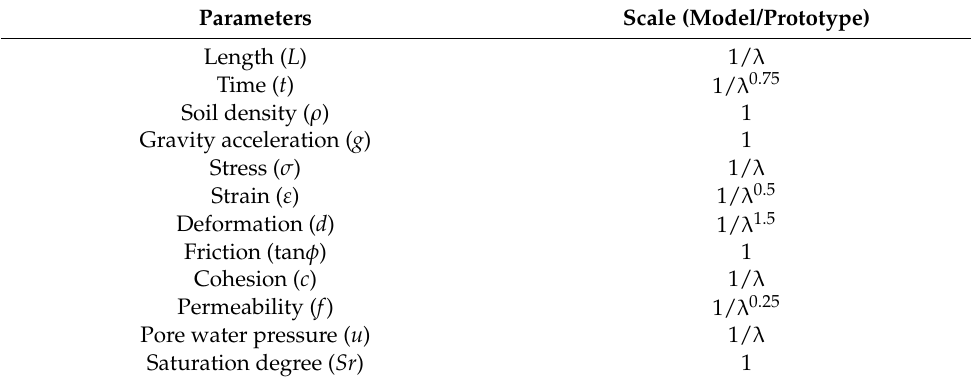
Table 5. Similarity laws applied in this